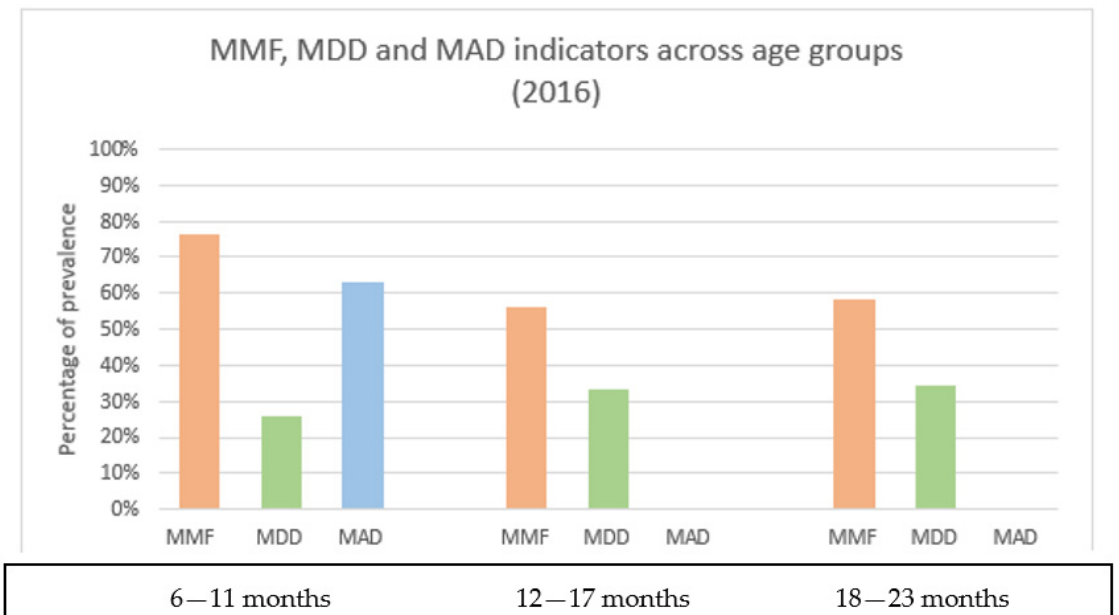
Overall, only one-third of children in the sample consumed four or more different food groups (Figure 1). The most consumed food group included cereals and roots, which accounted for 80% of reported foods by the participants. This was followed by fruits and vegetables (55%), and legumes (45%), showing that the diet was largely vegetarian. Alt- hough flesh foods, including meat and other animal products, counted for 30% of eaten foods among the children, meals containing eggs were not frequent (10%). The consump- tion of sweets was also generally limited (10%), but fats and oil were added to main meals (33%). No substantial differences were found in the consumption of food categories among the three age groups (supplementary material file S3). Complementary feeding prevalence varied geographically within Uganda, with ar- eas of high and low prevalence inconsistent across indicators (Figure 2A,B). A relatively low percentage of children living in the northern districts of Uganda met three or more complementary feeding indicators, although most of them started complementary feed- ing at 6 months of life. Conversely, in western and central Ugandan districts, we observed the highest percentage of children achieving three or more complementary feeding indi- cators, but this trend was not found for Kampala district. Sixty to eighty percent of chil- dren in many Ugandan districts reached the introduction of complementary feeding indi- cator, while the MDD and MAD indicators were only achieved by 20–40% of children in most of the regions. Figure 1. Complementary feeding practices indicators (2016) by child age groups.